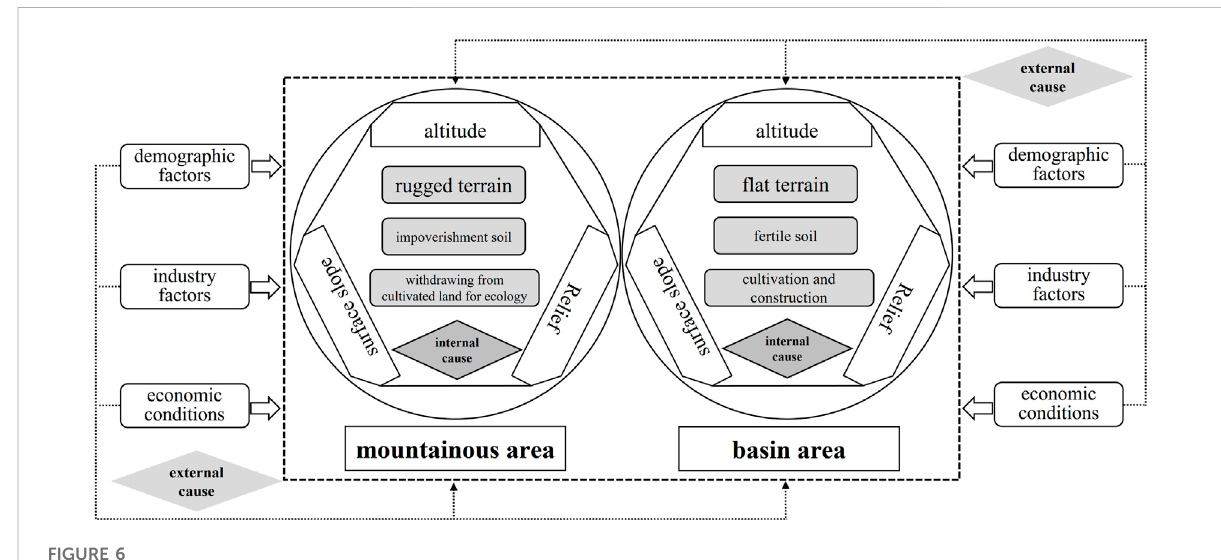
FIGURE 6 Motivation analysis of land use change in moutain-basin of Yuxi